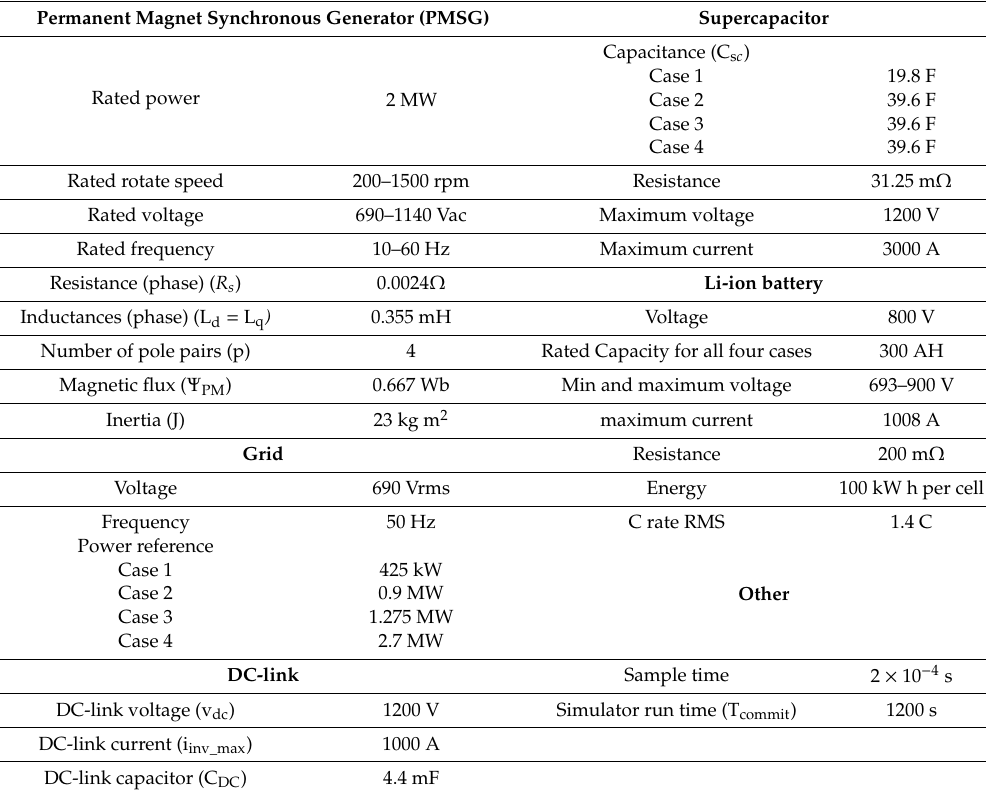
Table 1. Parameters used in the oscillating water column (OWC) system design.